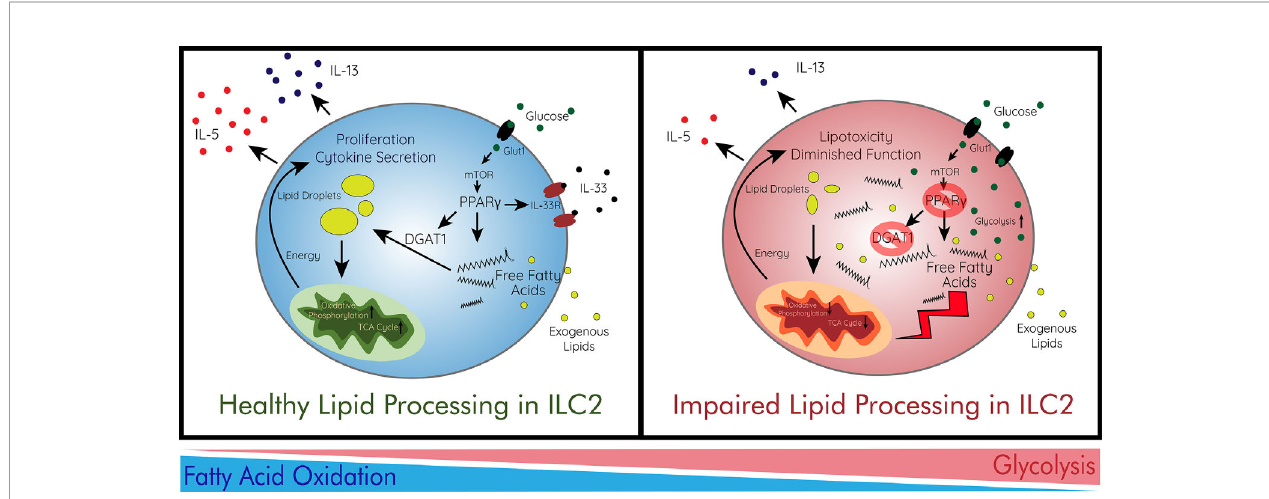
FIGURE 2 | Immunometabolism and Lipid Processing in ILC2s. ILC2s preferentially utilize fatty acid oxidation for their proliferation and cytokine secretion. In order to survive in the adipose tissue, ILC2s avoid lipotoxicity via storage of free fatty acids in lipid droplets. This process is regulated by the energy sensor mTOR which controls PPAR g and DGAT1 which ILC2s use to store fatty acids in droplets. mTOR is largely regulated by the abundance of glucose imported by Glut1. ILC2s then increase oxidative phosphorylation for their production of energy to enhance their function. When lipid processing is impaired, free fatty acids accumulate heavily in adipose ILC2s leading to lipotoxicity and diminished function. This can be caused by de fi ciencies in PPAR g or DGAT1. In addition, ILC2s intake more glucose and increase glycolysis as they are unable to utilize fatty acids effectively. This immunometabolic switch leads to decreased effector function and survival of ILC2s. Glut1, glucose transporter 1; IL, interleukin; IL-33R, IL1rl1; ILC2, type 2 innate lymphoid cell; mTOR, mammalian target of rapamycin; TCA cycle, citric acid